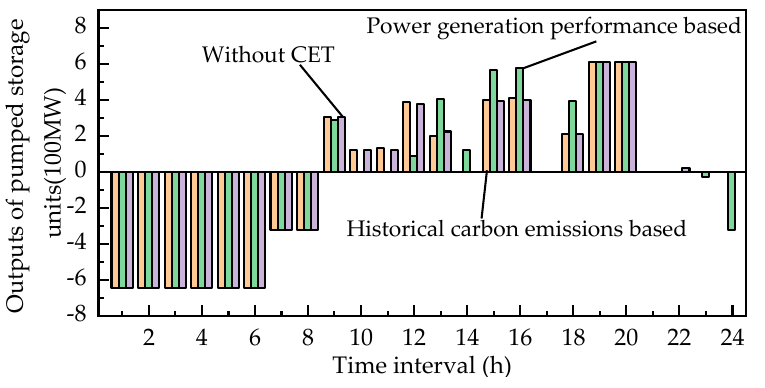
Figure 15. Comparison of outputs of pumped storage units.